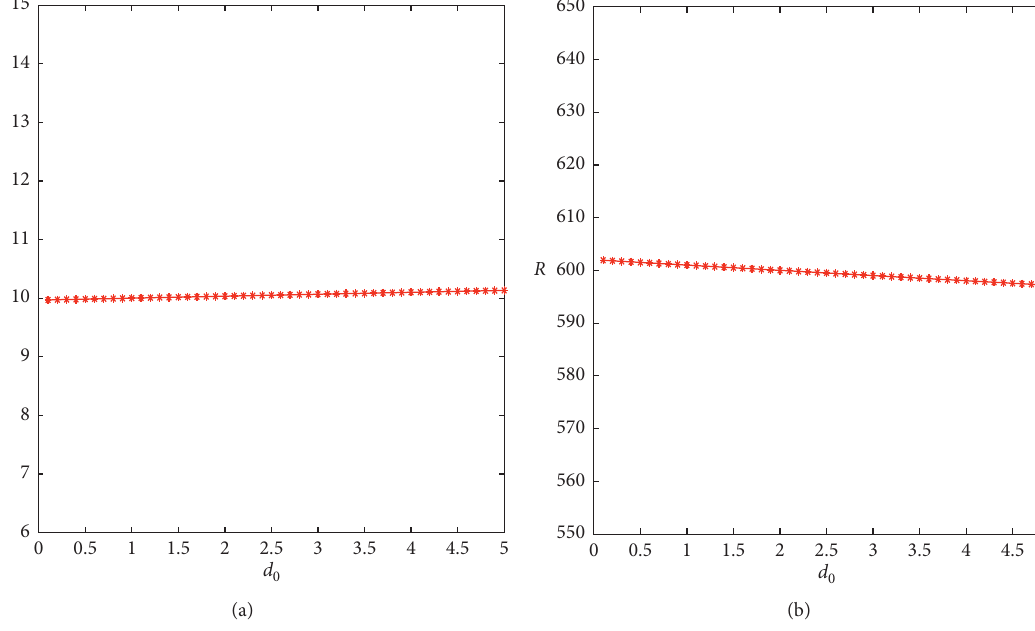
Figure 7: The synchronizability of multilayer star networks vs . varying the interlayer coupling strength d and a > Md ). (a) λ 2 with respect to varying d 0 . (b) R with respect to varying d 0